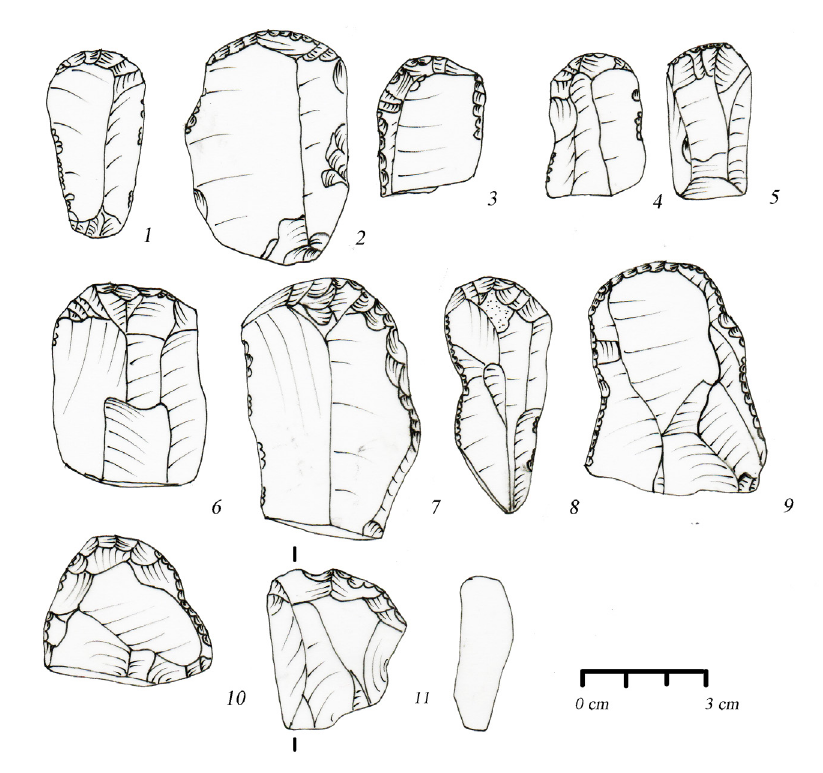
Figure 8. Frontal end-scrapers (1–10), Carinate type (11) (drawings M.C.